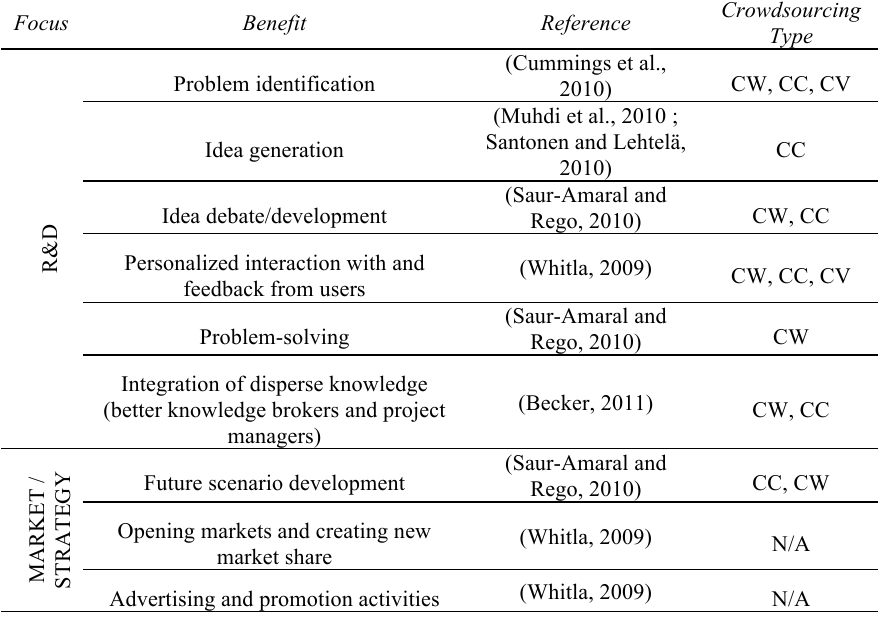
Table 2. Main benefits of crowdsourcing for R&D/innovation